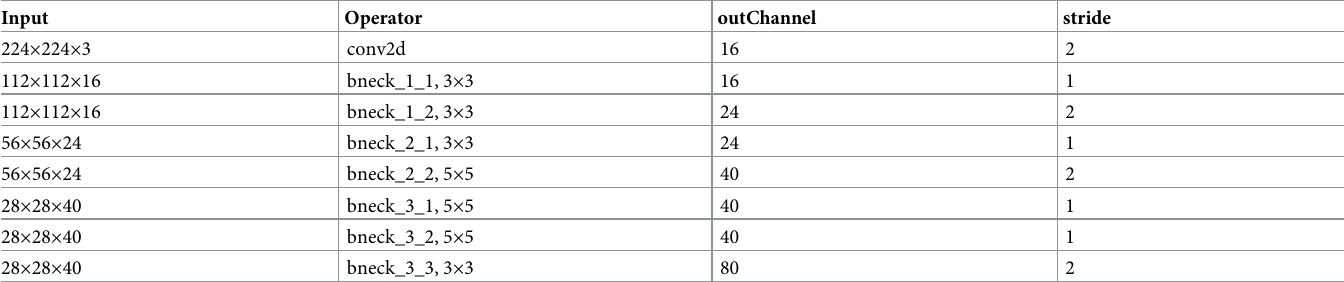
Table 1. MobileNetV3 feature extraction network